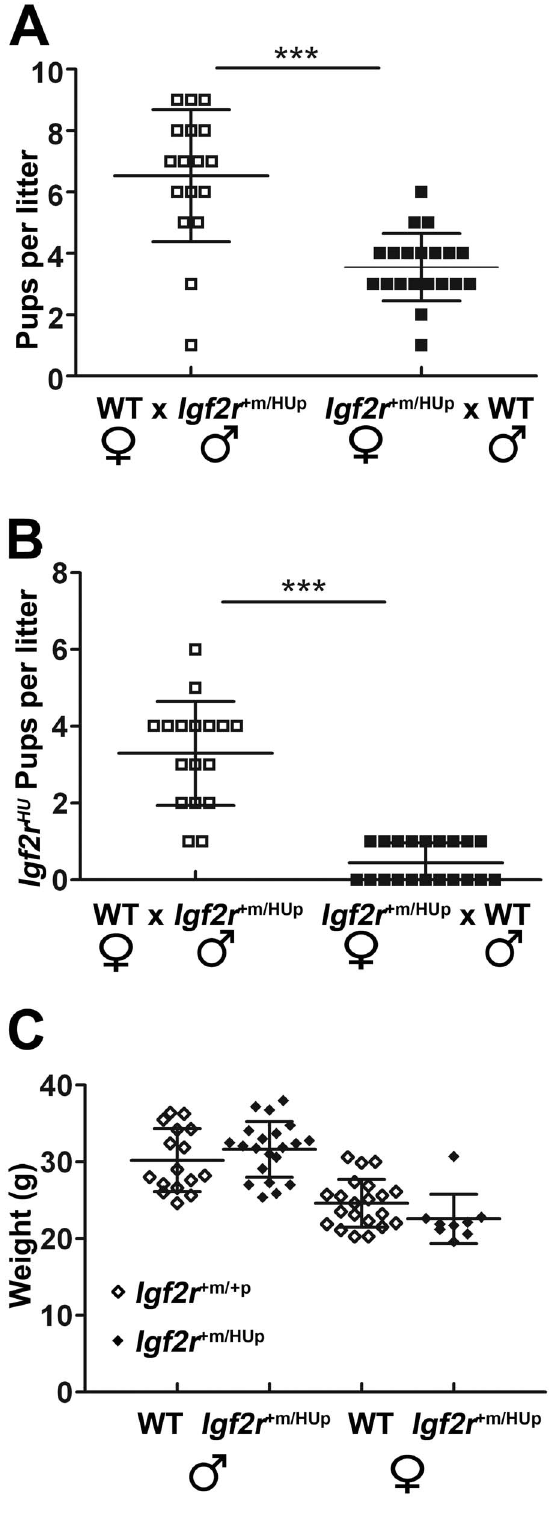
Figure 2. Maternal and paternal transmission of Igf2r + m/HU.p ( A ) Total number of neonates per litter at postnatal day 10 resulting from either paternal transmission (wild-type females crossed to Igf2r + m/HUp males, 8 pairs, 20 litters, open squares) or maternal transmission ( Igf2r + m/HUp females crossed to wild-type males, 4 pairs, 17 litters, closed squares). Litter sizes were significantly reduced following